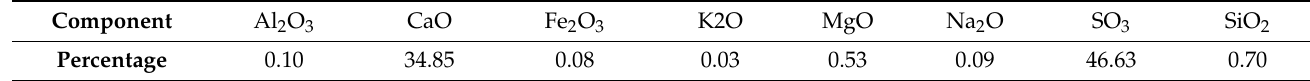
Table 1. Gypsum plaster chemical composition.